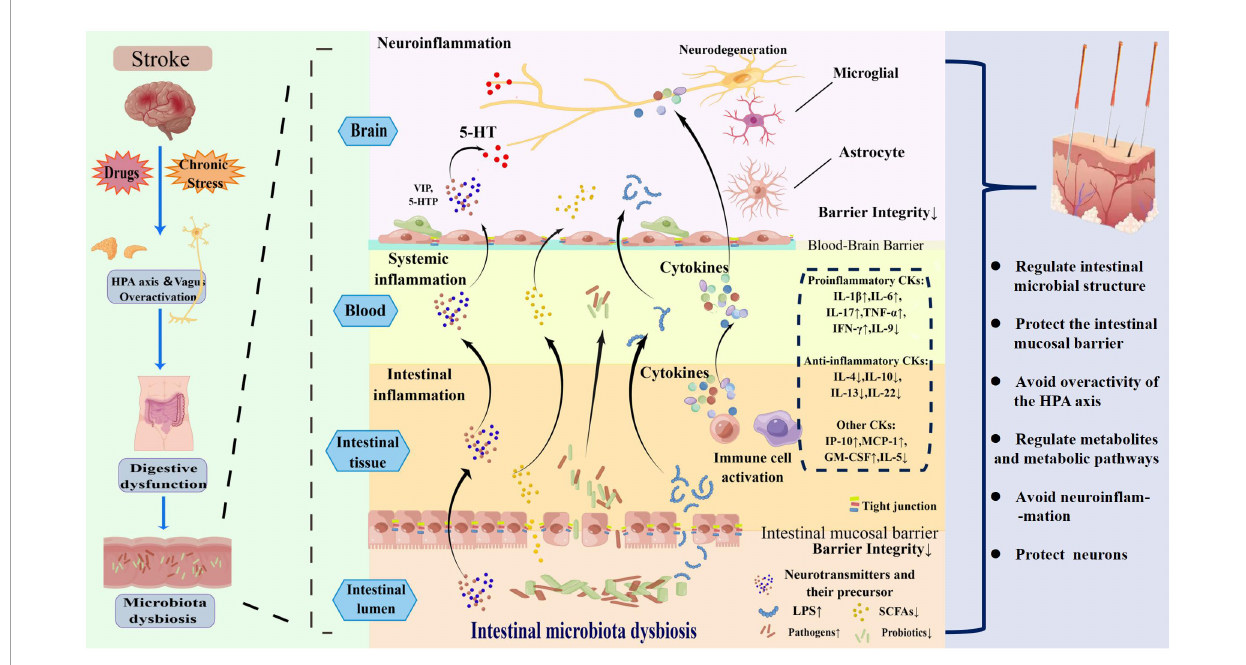
FIGURE2 The mechanism of intestinal microbiota dysbiosis induced by post-stroke depression (PSD) and how acupuncture regulates the intestinal microbiota to treat PSD.